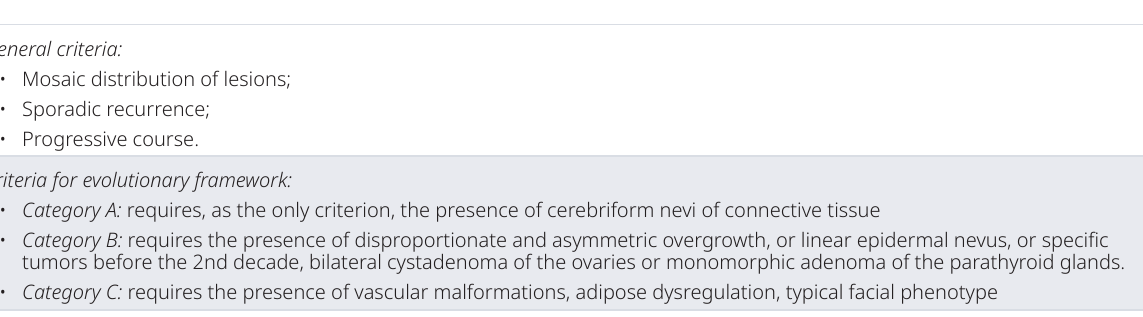
Table 1. Diagnostic criteria of proteus